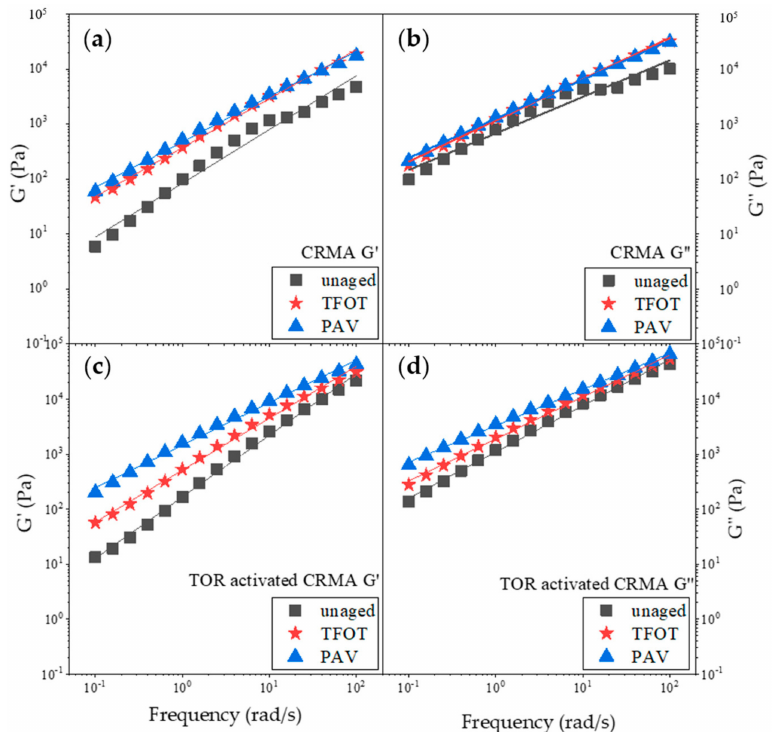
Figure 6. Viscoelastic parameters versus frequency of unaged and aged crumb rubber modified asphalt (CRMA) and TOR-activated CRMA at 60 ◦ C. ( a ) CRMA G (cid:48) ; ( b ) CRMA G”; ( c ) TOR activated CRMA G (cid:48) ; ( d ) TOR activated CRMA